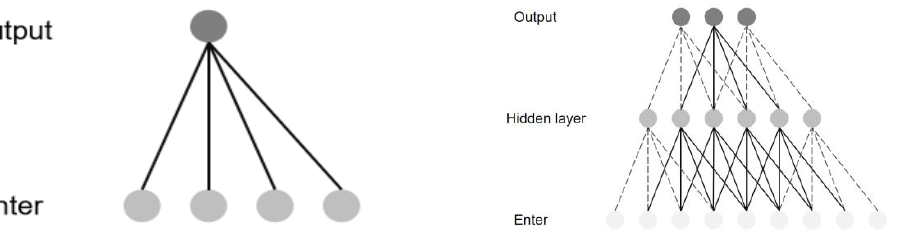
Figure 1. Causal Figure 1. Causal convolution.